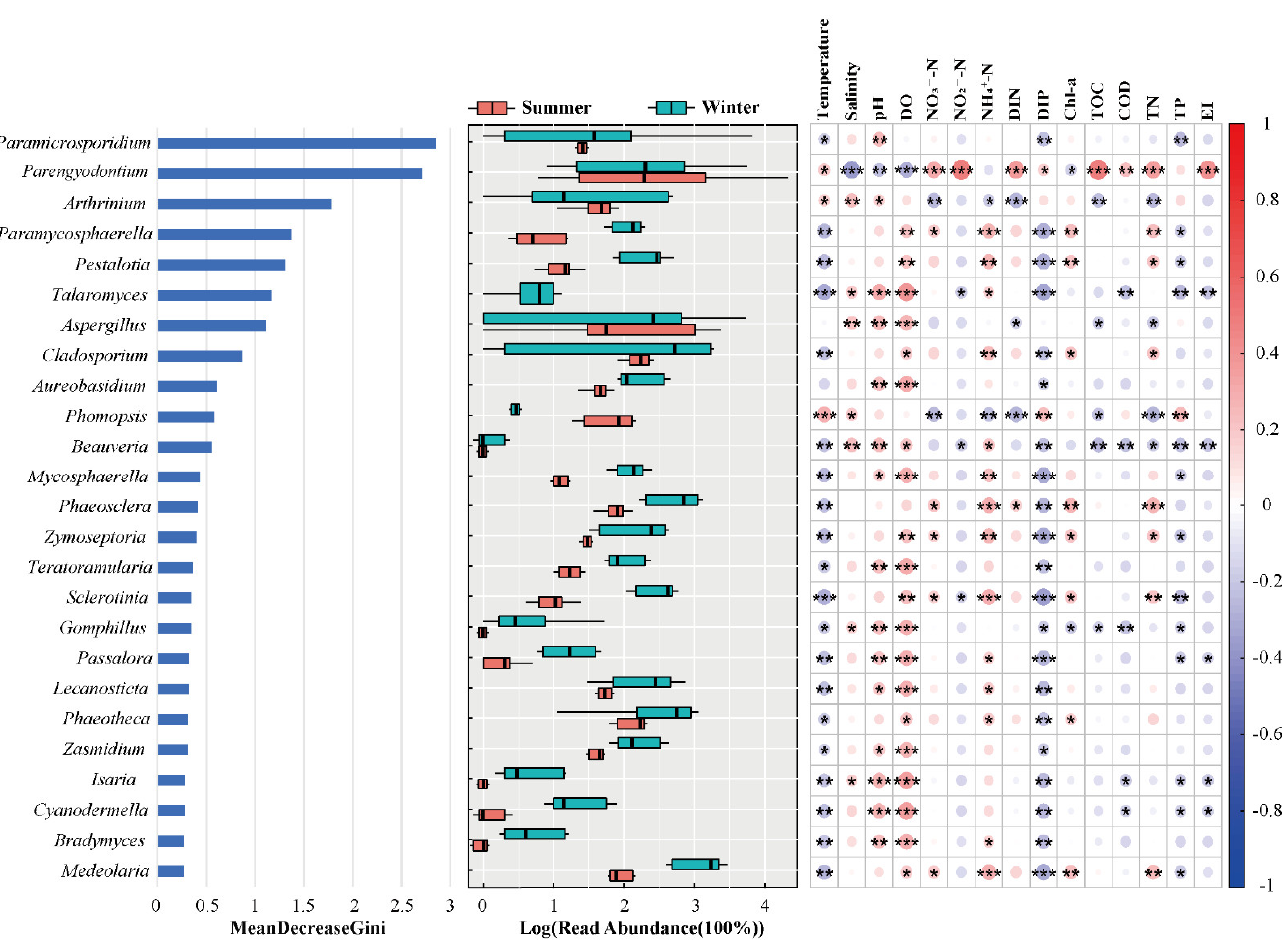
Figure 5. Random forest classification of the top 25 important genera. Left: The top 25 taxa analyzed using the Gini index, representing the importance of each genus in distinguishing different groups. Middle: Read abundances of the top 25 genera. Right: Pearson correlations between the relative abundances of the top 25 genera and environmental and nutrient factors. *: p < 0.05; **: p < 0.01; ***: p < 0.001.